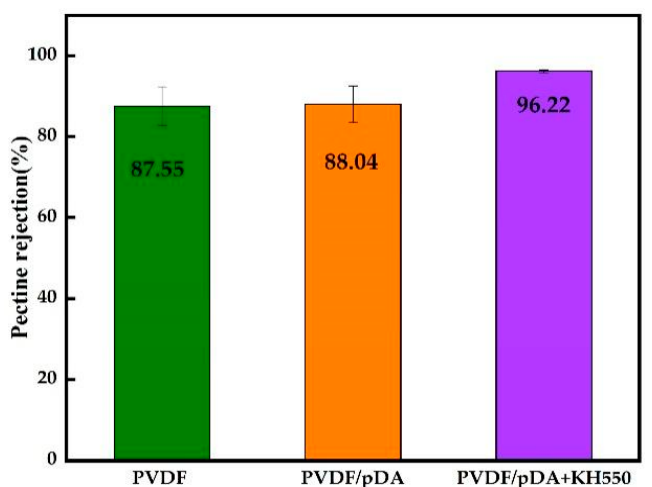
Figure 8. Pectin rejection by the pristine and coated membranes under pectin solution.